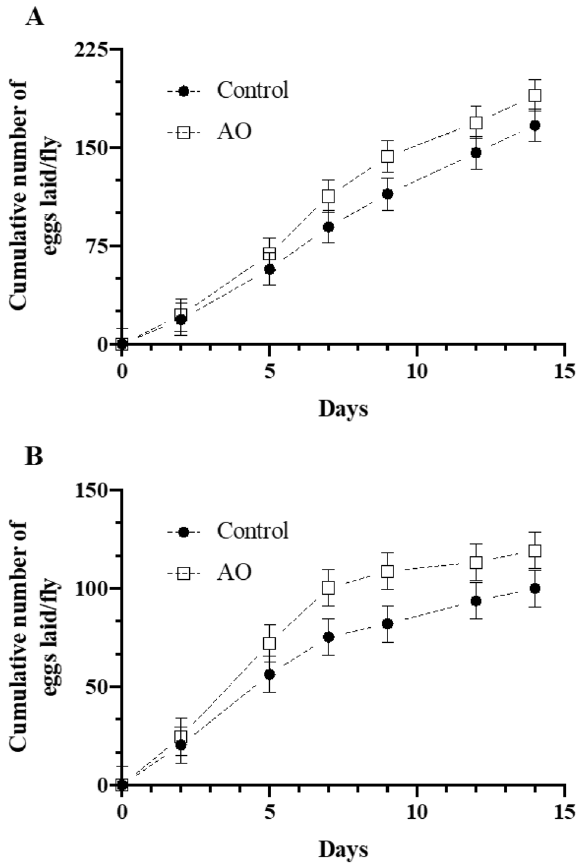
Figure 1. Cumulative egg production by D. melanogaster flies fed control or control medium supplemented with 5% of an Aspergillus oryzae postbiotic (AO). Mated, age-matched w 1118 females were maintained at a constant ambient temperature of either ( A ) 25 °C (standard culture conditions) or ( B ) 29 °C for 14 days. Data are least squares means ± SEM from 5 independent experiments (n = 5/experiment). Treatment × day interaction was not significant at 25 °C ( P = 0.732) and 29 °C ( P = 0.867). The effect of AO was significant at 25 °C ( P = 0.021) and 29 °C ( P =